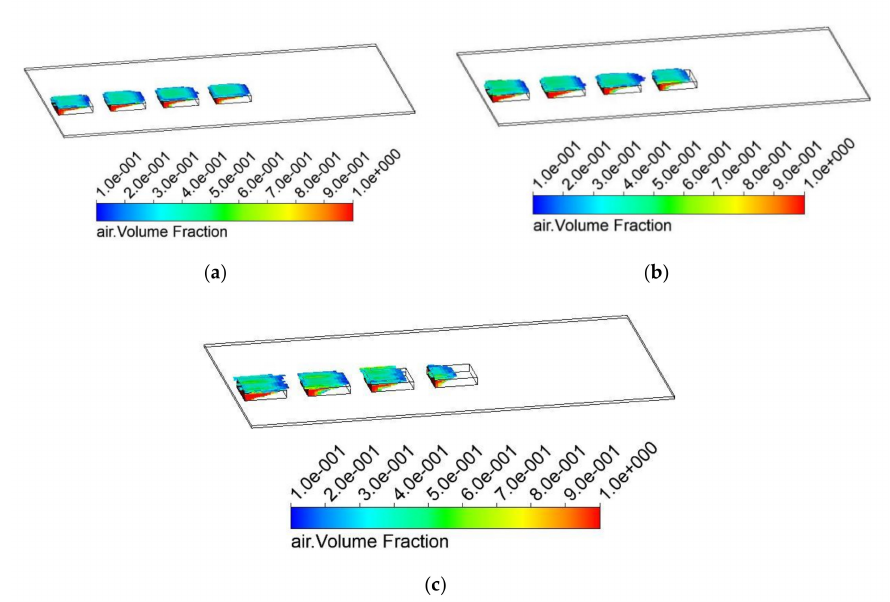
Figure 28. The air volume fraction is generated by a partial texturing configuration with dimples side 50 µ m and gap 3 µ m, sliding velocity 10 m / s. Set B of the cavitation coe ffi cient. Only the portions of the mesh where the volume fraction of air is greater than 10% are highlighted. ( a ) Saturation pressure − 0.7 bar; ( b ) Saturation pressure − 0.5 bar; ( c ) Saturation pressure − 0.3